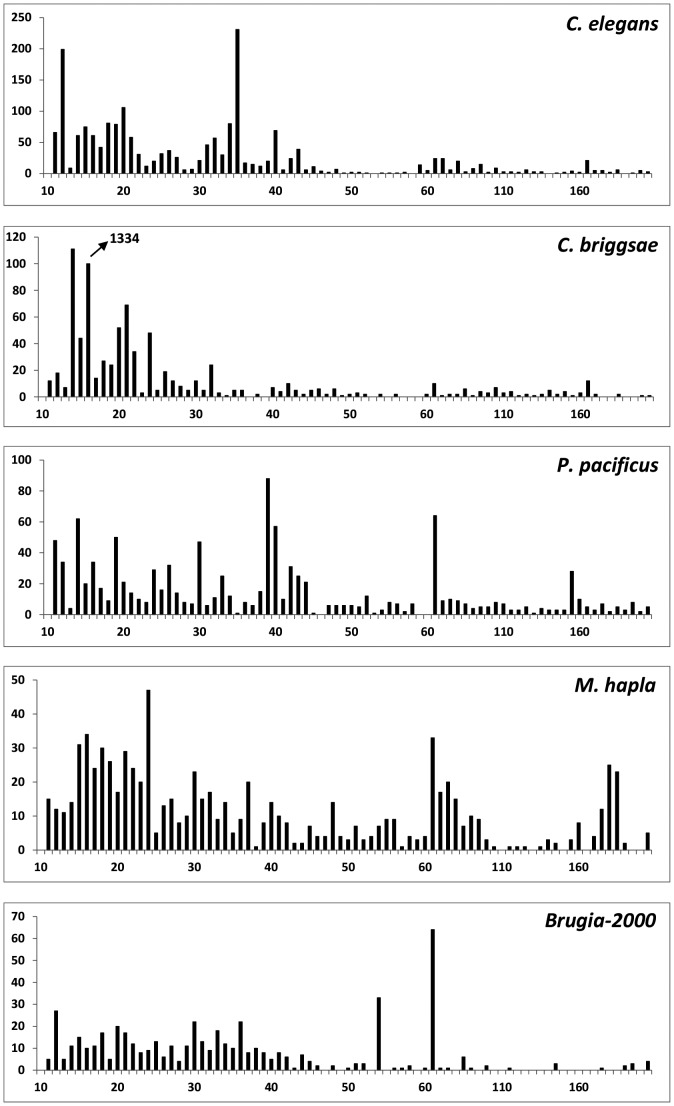
Distribution of motif sizes in the satellites of different nematodes.For sequences longer than 60 bases the data have been merged in bins of 5 bases. The percentage of short motifs (<50 bases) is the largest in all cases, with up to 95% in C.briggsae. Hexadecamer motifs are extremely abundant in this species; their actual frequency is indicated by an arrow in the figure.